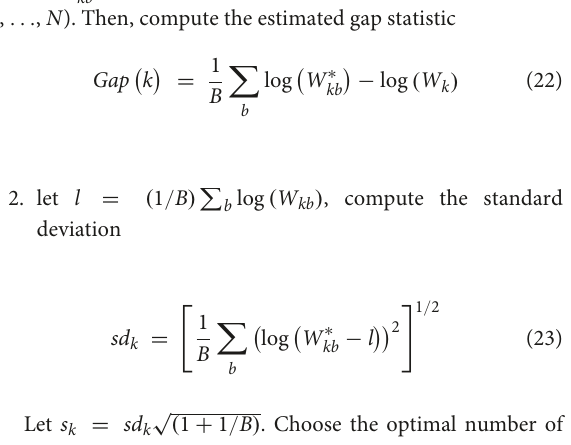
The B reference datasets is uniformly generated by randomly sampling from the bounding rectangle of the original dataset. By Eq. 21, W ∗ is computed for each k and b ( b = 1, 2, . .. , B , k = kb